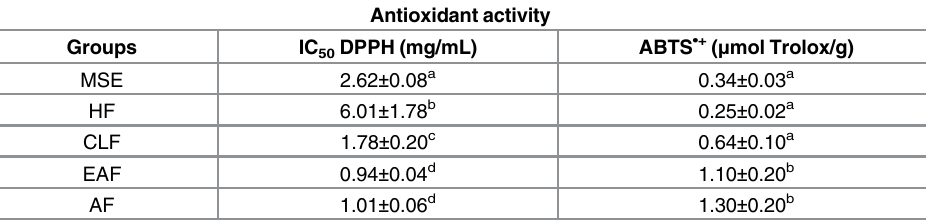
Table 3. Antioxidant activity of MSE and fractions using ABTS (cid:129) + and DPPH method.